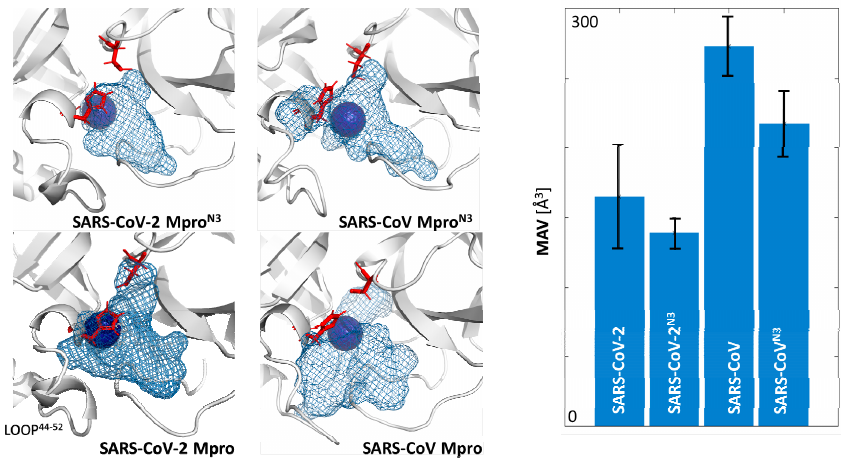
Figure 2. The di ff erences between the maximal accessible volume of the binding cavities calculated during molecular dynamics (MD) simulations of both apo structures of Mpros (SARS-CoV and SARS-CoV-2) and structures with co-crystallised N3 inhibitor (SARS-CoV N3 and SARS-CoV-2 N3 ) used as di ff erent starting points for 10 replicas of 50 ns per structure. The position of the blue sphere (hot-spot with highest density) in each structure reflects the position of the catalytic water molecule.